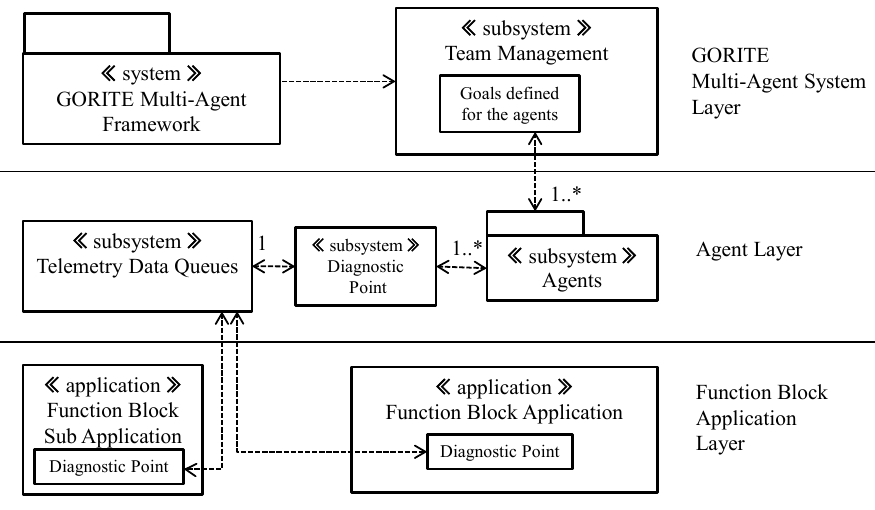
Figure 5. The layered architectural style of the fault diagnostic